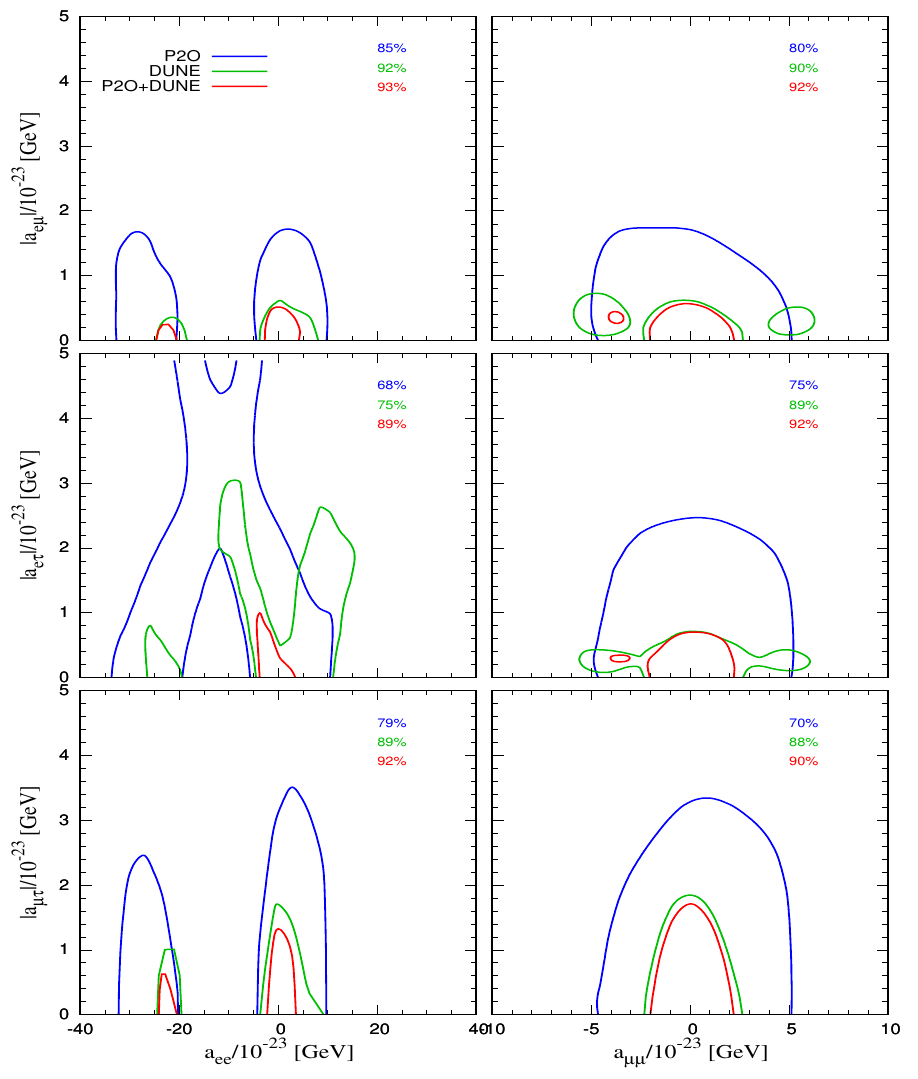
Figure 5 . This shows the exclusion regions in the parameter space consisted of one diagonal (along the horizontal axis) and one off-diagonal LIV parameter (vertical axis) for P2O only (blue contours), DUNE only (green contours) and P2O combined with DUNE (red contours). The results are shown at the confidence level (C.L.) of 95% . The triplet of numbers ( % ) in each panel indicates the area lying (excluded) outside the 95% C.L. contours, expressed as a percentage of the total area of the parameter space considered. The numbers are shown for the three cases, — blue for P2O only, green for DUNE only, and red for the combined case of (P2O + DUNE), and thus they offer a measure of the exclusion capabilities of each experimental configuration for each relevant parameter